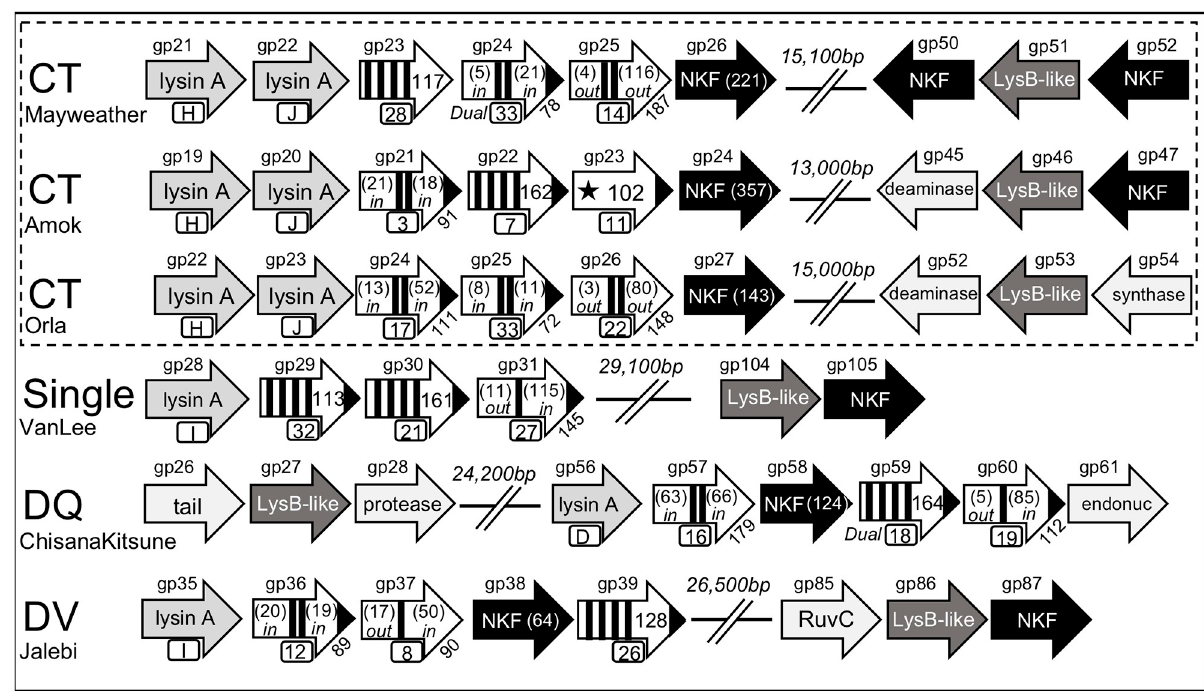
Fig 8. Genomic organization of lysis cassettes with a lysA and three transmembrane genes and a predicted lysB at a distal location. The genomic structure is shown and the key to the schematic is presented in Fig 1. The direction of transcription of each gene is represented by the arrowhead. Dual = Gene has a possible dual start motif and contains a basic amino acid between the two start